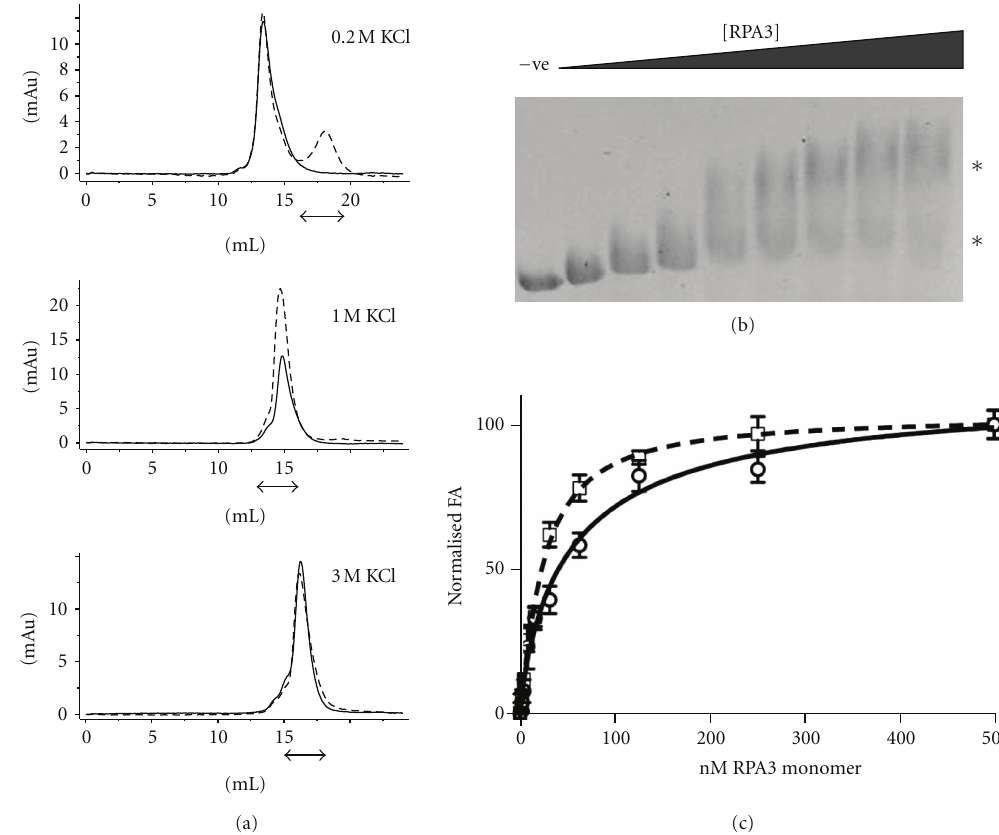
Figure 2: (a) Size exclusion profiles of HvRPA3 in the presence (dashed line) and absence (solid line) of equimolar (based on monomeric protein concentration) 18mer ssDNA in 0.2, 1, and 3 M KCl. The x axis shows elution volume (mls) and the y axis absorbance at 280 nm. Arrows indicate the elution position of ssDNA. (b) Agarose gel retardation assay of HvRPA3 titrated into reactions containing PhiX174 ssDNA. − ve indicates negative control containing no HvRPA3. Increasing quantities of HvRPA3 were used − 11, 22, 33, 55, 75, 98, 120, and 125 μ g. Asterisks indicate the concentration-dependent, di ff erentially migrating forms of complex. (c) Titration of the indicated concentrations of HvRPA3 (calculated for monomer due to the potential independence of binding sites in the dimeric form) plotted against normalised FA of the Cy5-labelled 18mer in 1M (solid line) and 3 M (dashed line) KCl. Data were fitted to a Hill binding model. Produced using GraphPad